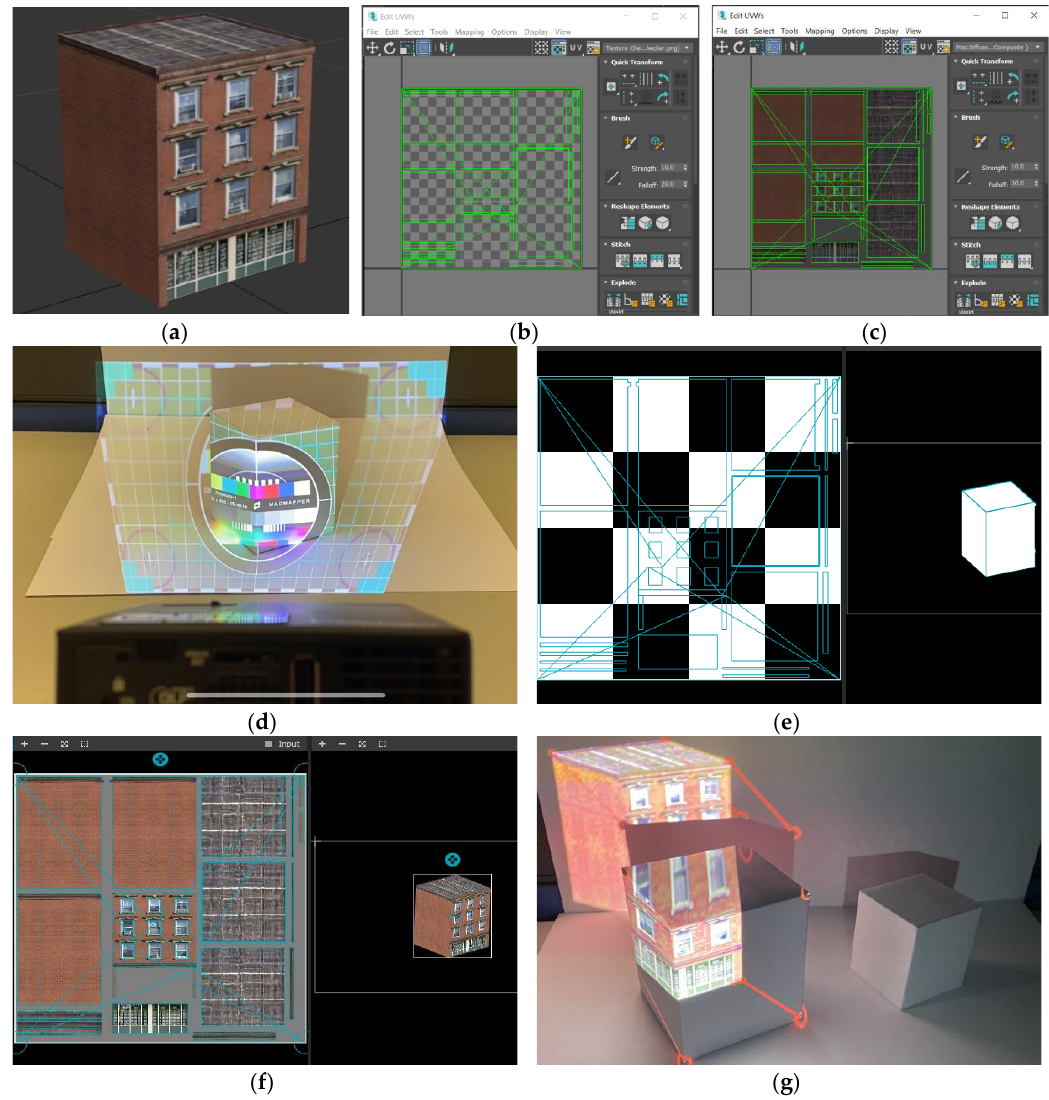
Figure 3. Case procedures. ( a ) 3D building model with material added; ( b ) UV map generated in 3ds Max; ( c ) Texture plan generated in 3ds Max; ( d ) Setting projector and physical model; ( e ) 3D raw model with UV map in MadMapper; ( f ) Textured model in MadMapper; and ( g ) Geometric matching.